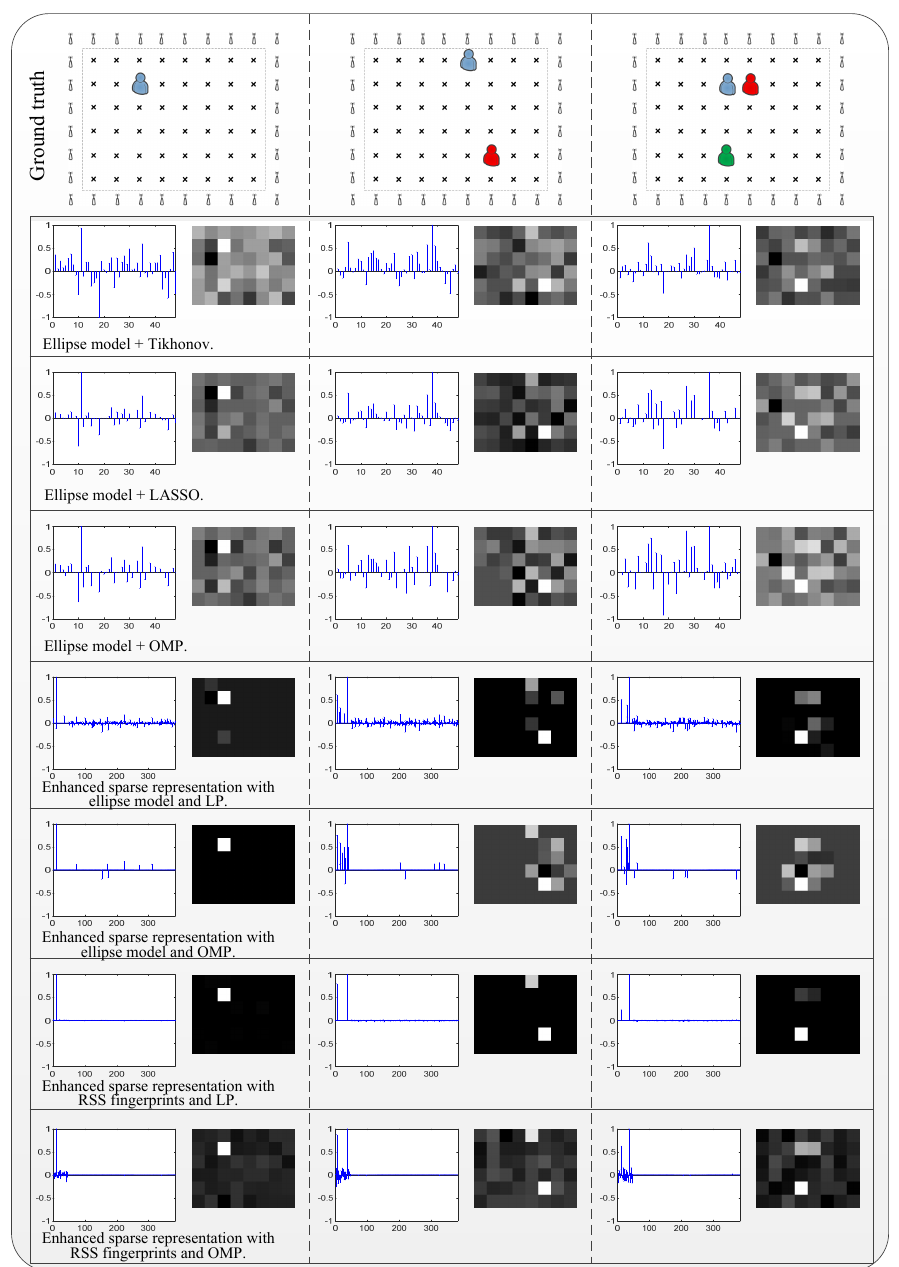
Figure 5. Imaging comparison of localizations with different methods in the indoor LOS